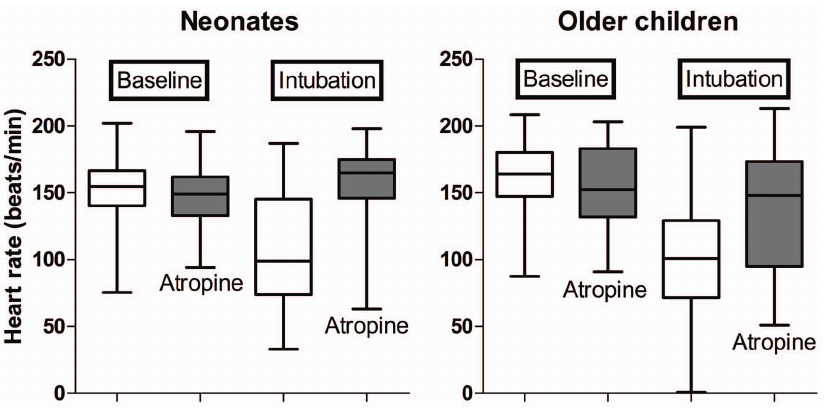
Figure 4. The influence of atropine of the change in heart rate during intubation of the two age sub-groups.